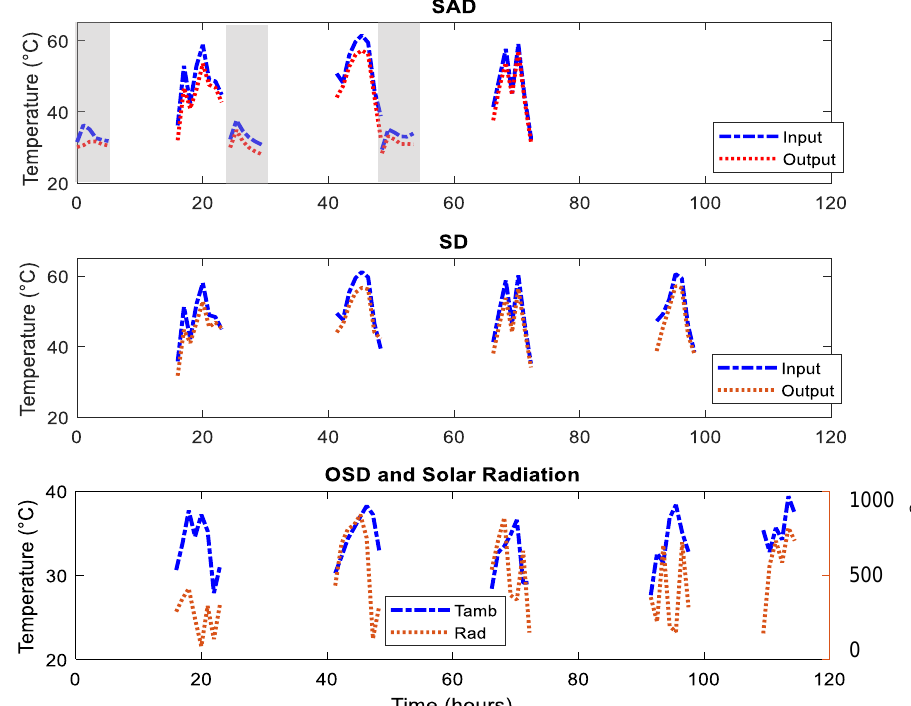
Figure 3. Drier cabinet input and output air temperatures T4 and T5 (night), T2 and T3 (day) for SAD (top graph), T2 and T3 (day) for SD (middle graph) and ambient temperature T1 for OSD (See Figure 2) and radiation (bottom graph). The grey portions represent the night drying.